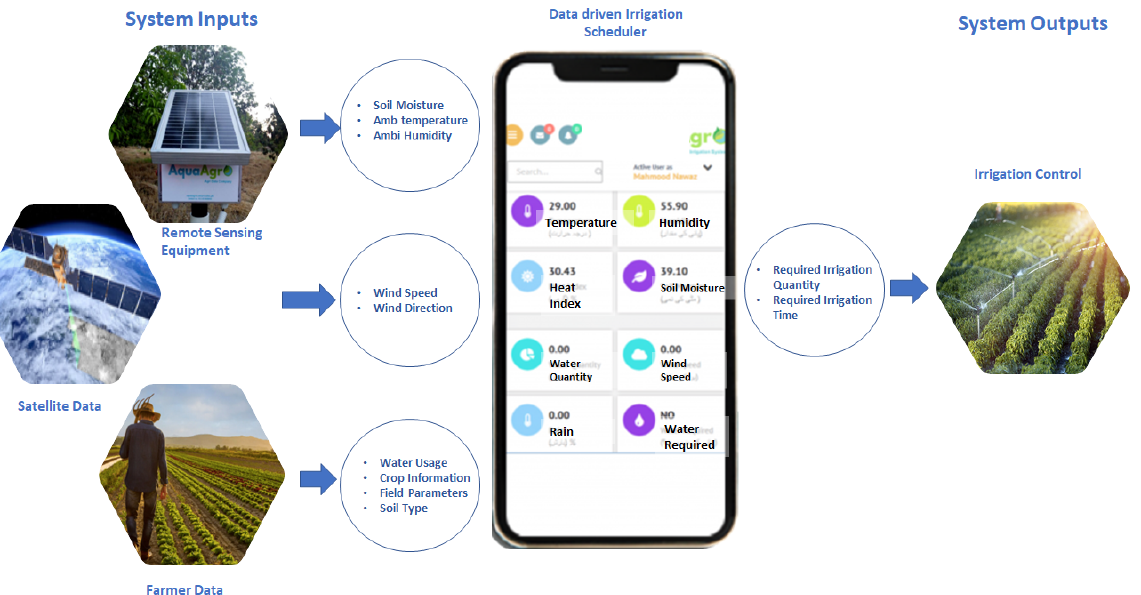
Figure 3. Overall architecture of agriculture-based DSS .